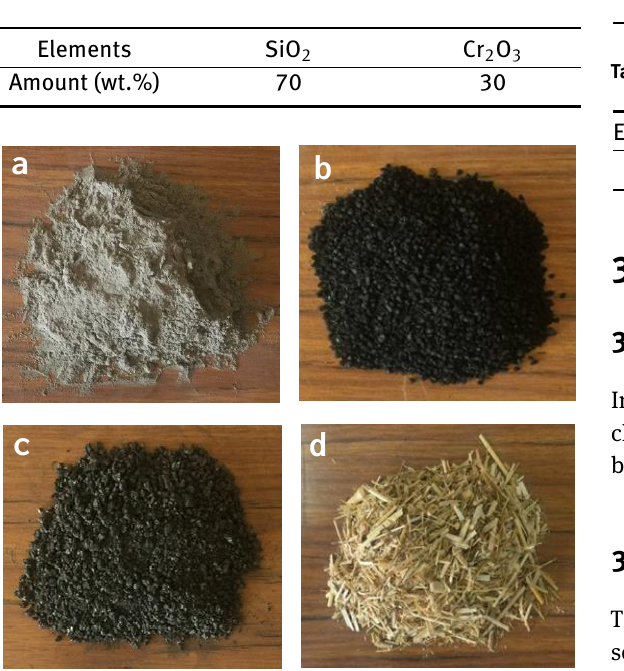
mentandimprovementinhardness,tensilestrength,wear,